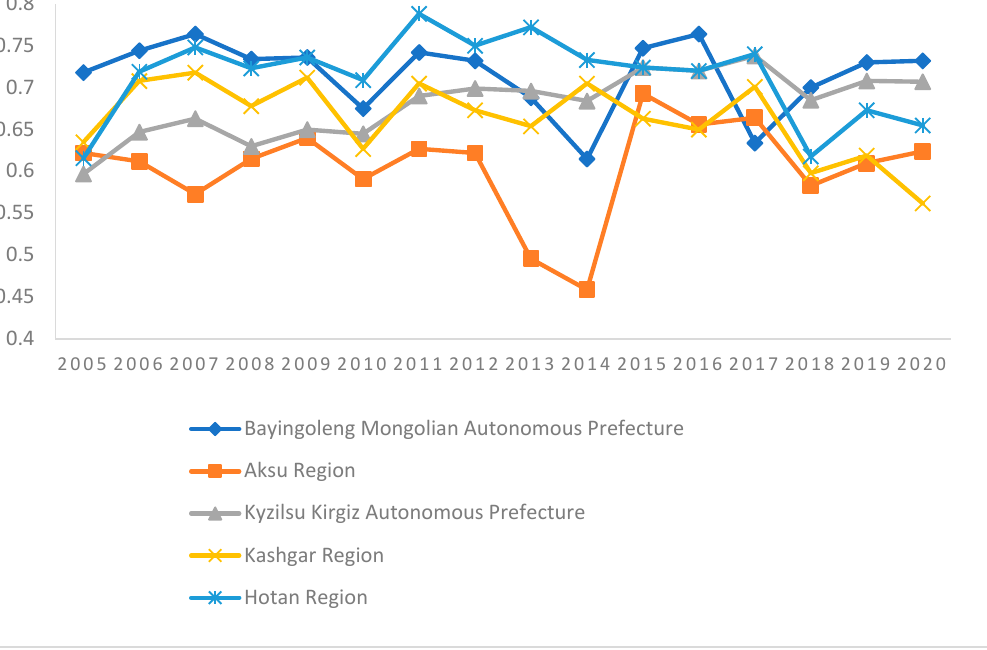
Table 7. Global Moran index of coupling coordination degree in Tarim River Basin from 2005 to